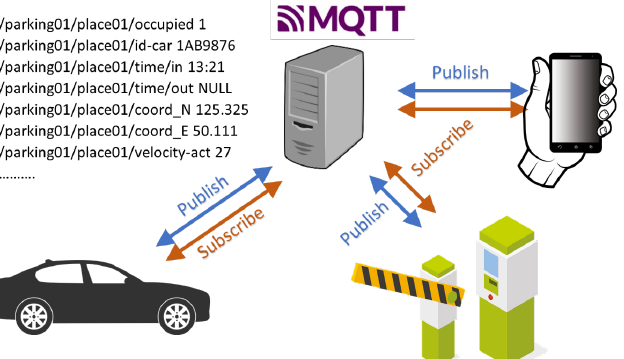
Figure 2. Client–server topology of the distribution of MQTT server topics among clients in the